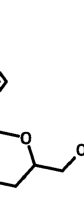
Figure 1. Chemical structure of ganciclovir.